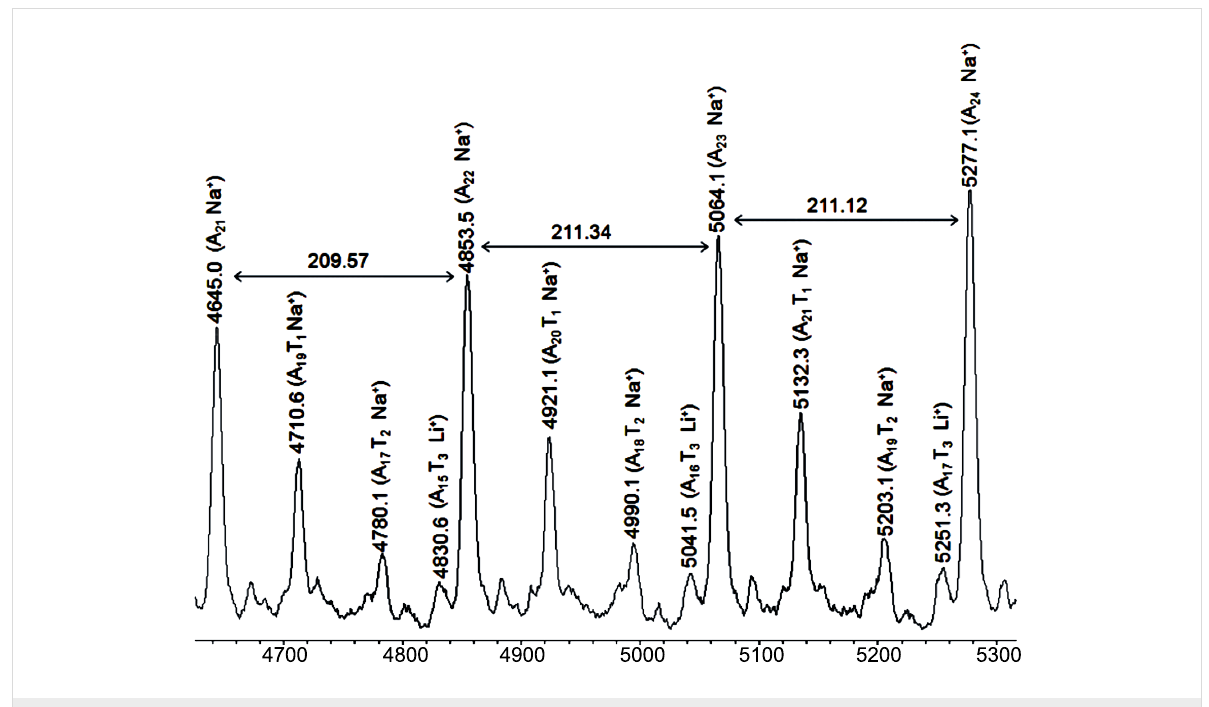
Figure 10: MALDI-TOF mass spectrum of BCP-A 25 T 2 13 synthesized with catalyst U3 .